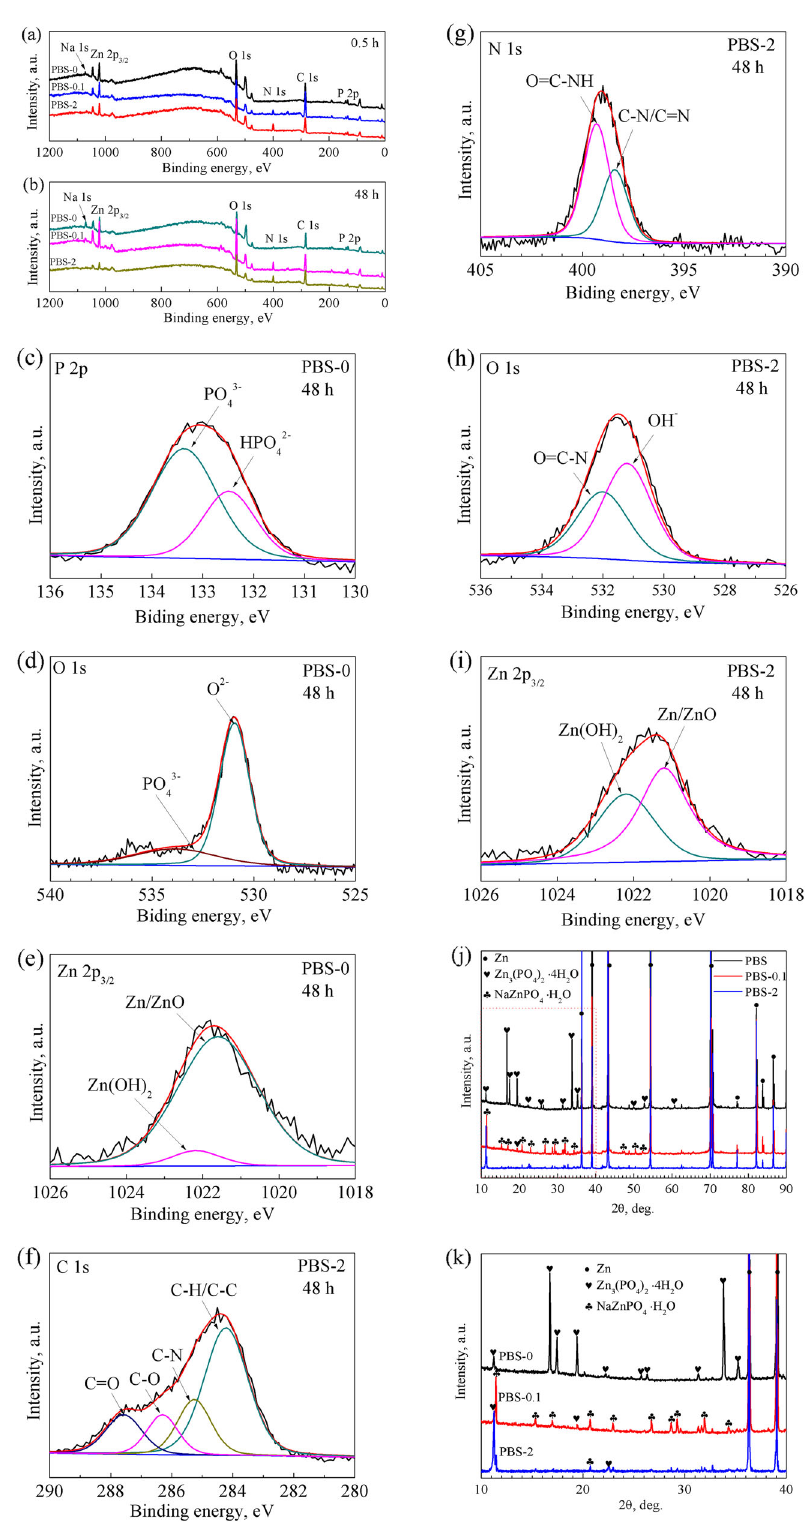
Fig. 5 XPS survey of pure Zn after immersion in PBS, PBS- 0.1 and PBS-2 for a 0.5 h and b 48 h; High resolution XPS spectra of c P 2p, d, h O 1 s, e, i Zn 2p 3/2 , f C 1s, g N 1 s after immersion in c – e PBS-0 and f – i PBS-2 for 48 h; j XRD patterns of the pure Zn after immersion in PBS, PBS-0.1and PBS-2 for 48 h, k XRD patterns in the range of 10 –